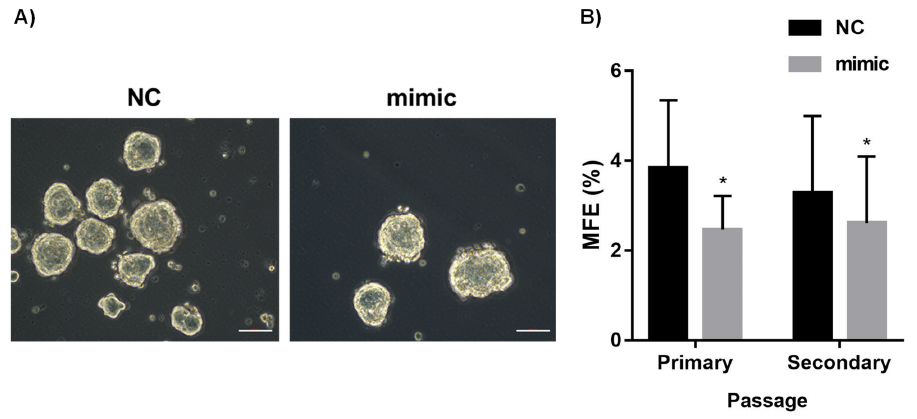
Figure 4. Mammosphere-forming ability of miR-126 mimic compared to NC-transfected cells. ( A ): Representative images of mammospheres formed by NC- and miR-126-transfected MCF-7. Scale bar: 100 µ m. ( B ): Mammosphere-forming efficiency (MFE) of transfected MCF-7. Error bars represent SEM (n = 4). * denotes p < 0.05.